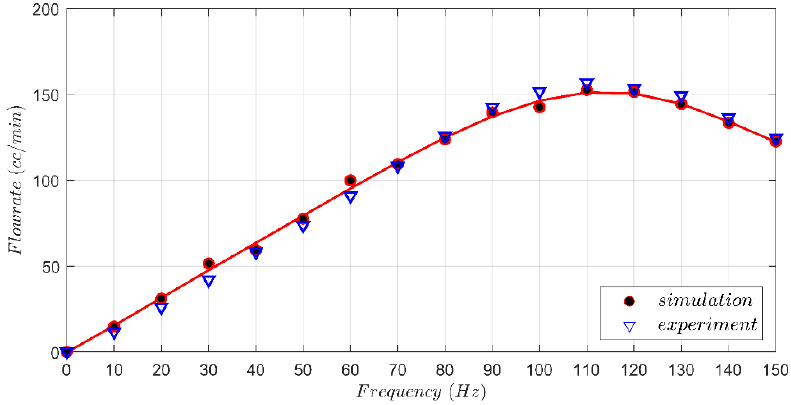
Figure 12. The flow rate experiment results at several driving